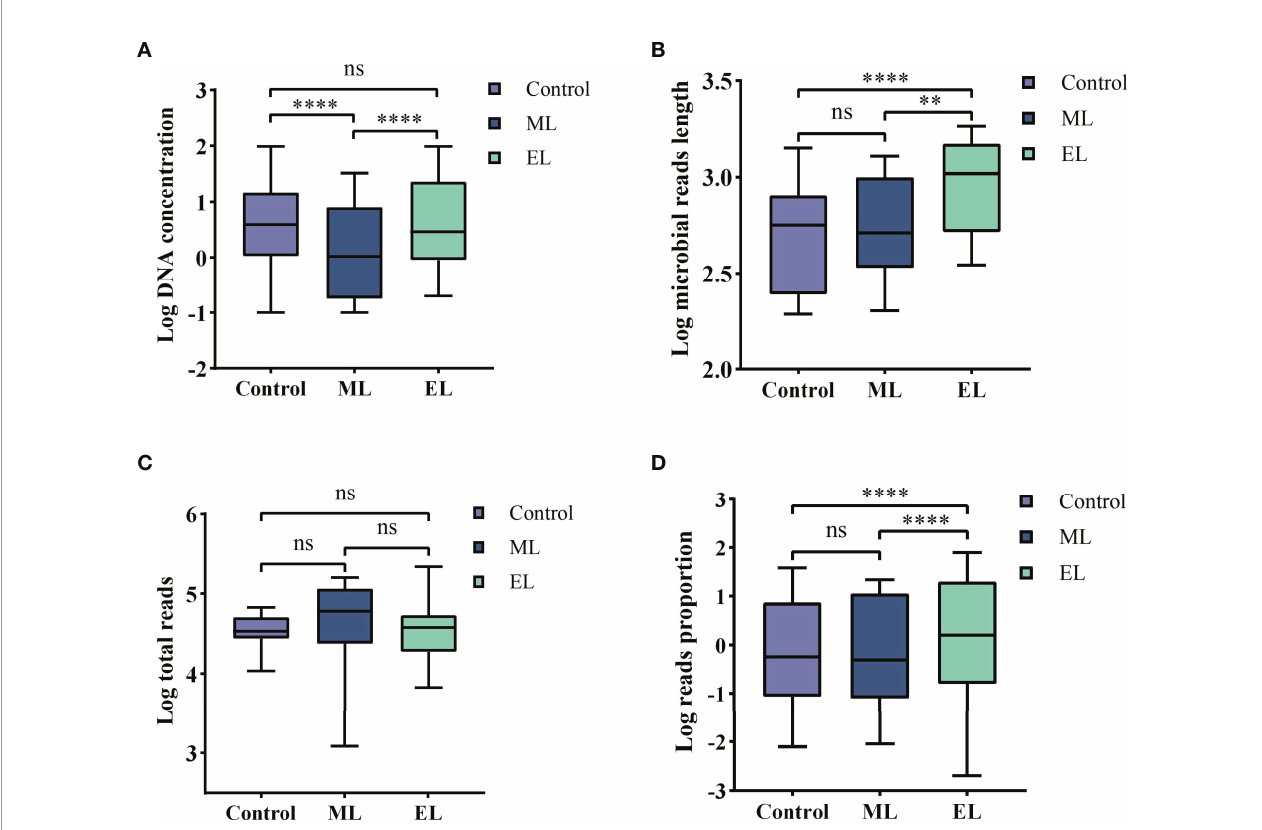
FIGURE 3 | Boxplots demonstrating the statistic difference analysis for the three DNA extraction methods. Median values are indicated by the line within the boxplot. The box extends from the 25th to 75th percentiles, and whiskers indicate the minimum and maximum values. **** P < 0.0001; ** P < 0.01; ns, nonsigni fi cant. (A) Log DNA concentration. (B) Log average length of microbial reads. (C) Log total reads. (D) Log mapped reads proportion of the speci fi c